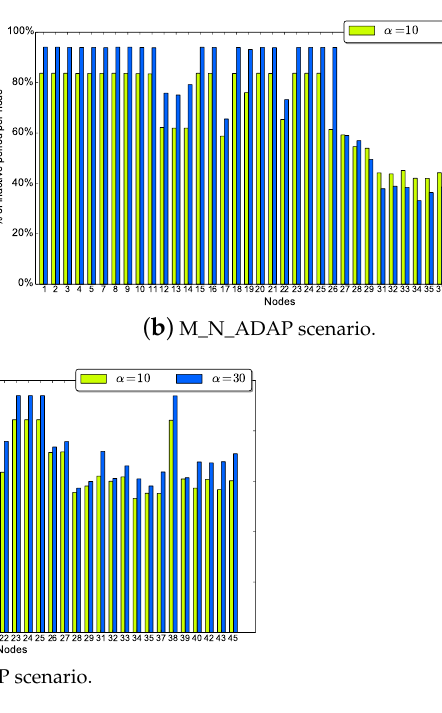
Figure 11. Individual duty